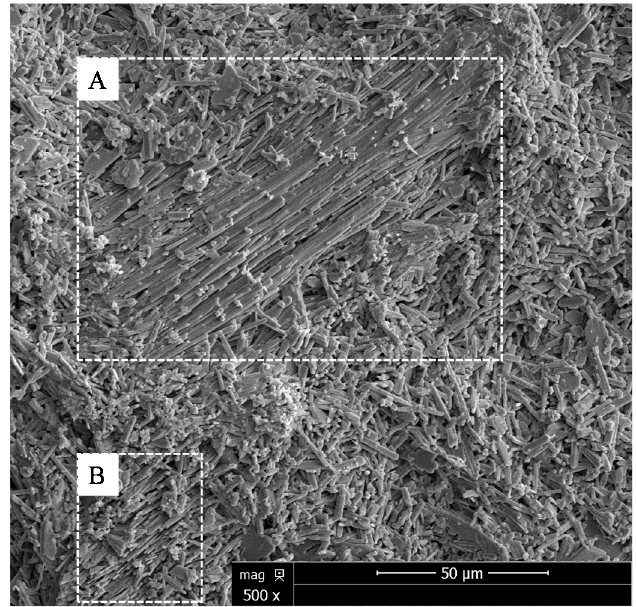
Figure 9. SEM scanning image of S2 (500 times).